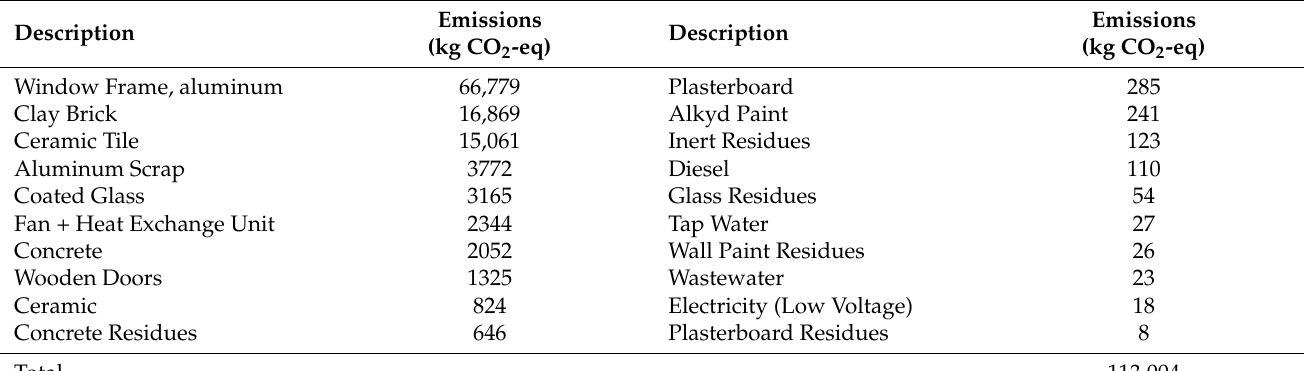
Table 8. GHG emissions for the administrative building.